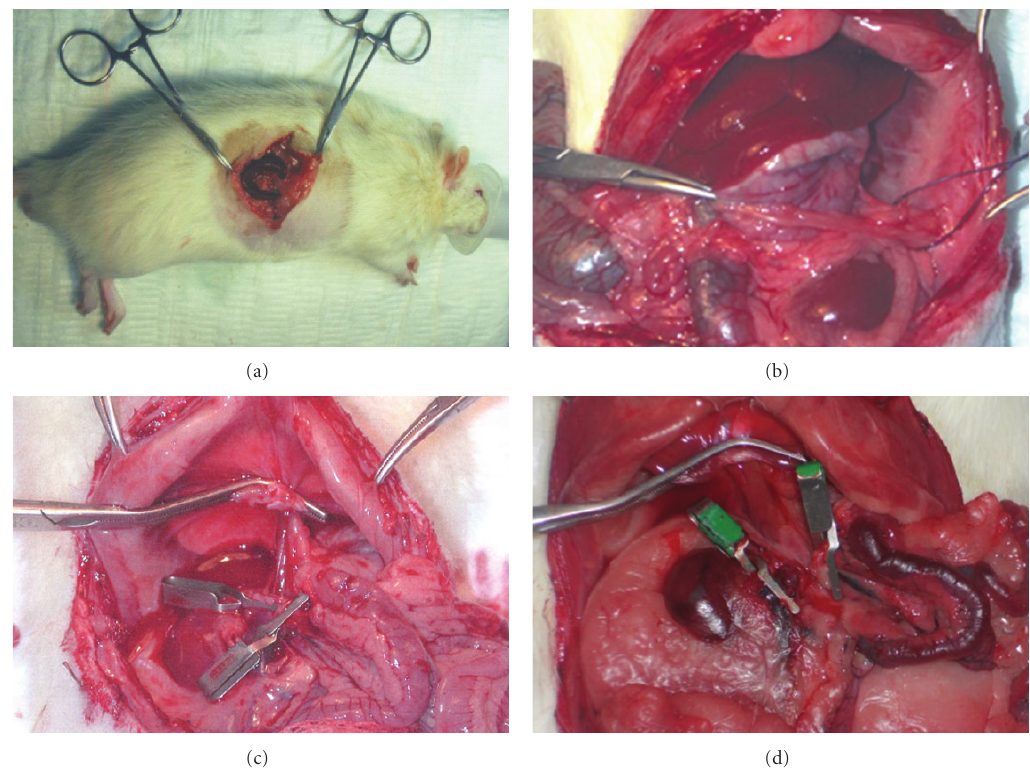
Figure 3: (a) Transposition of the spleen to the subcutaneous tissue in the left hypochondrium. (b) Abdominal cavity after three weeks of the transposition of the spleen. (c) Anhepatic phase in recipient with SPS. No intestinal congestion is observed secondary to clamping of di ff erent vessels. (d) Anhepatic phase in recipient without SPS. Intestinal congestion is observed secondary to clamping of the di ff erent